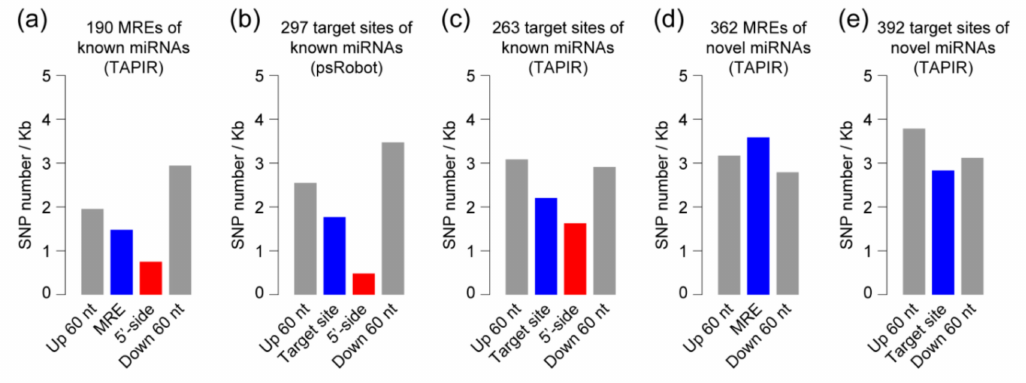
Figure 3. Sequence conservation of miRNA response elements (MREs) and target sites of known and potentially novel miRNAs. Single nucleotide polymorphism (SNP) density distribution along the miRNA binding sites and the flanking regions (up- and down-stream 60 nt, respectively) in ( a ) competing endogenous RNAs (ceRNAs) of known miRNAs, ( b ) target genes of known miRNAs by psRobot software and ( c ) by TAPIR program. SNP density distribution along the miRNA binding sites and the flanking regions in ( d ) ceRNAs of potentially novel miRNAs and ( e ) target genes of potentially novel miRNAs by TAPIR program. There were four predicted target genes by using the psRobot program for potentially novel miRNAs, but no SNP site existed at the four target sites and their flanking regions. “MRE and target site” indicate binding regions recognized by mature miRNA sequences on predicted ceRNA and target genes respectively, and are marked in blue. “5 (cid:48) -side” represents binding regions recognized by the 2nd to 7th nucleotides from the 5 (cid:48) end of miRNA mature sequences (marked in